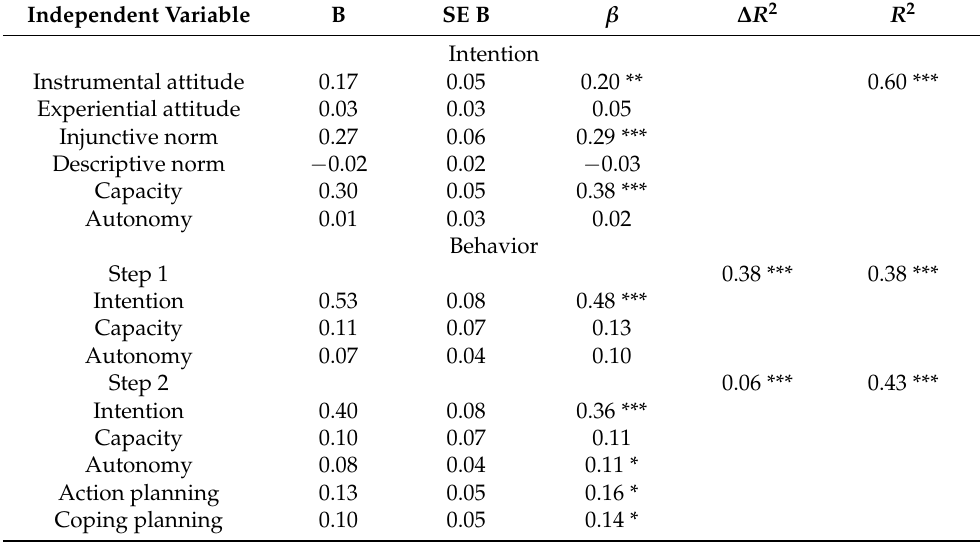
Table 4. Regression analyses predicting blood glucose monitoring intention (N = 273) and behavior (N = 256). B